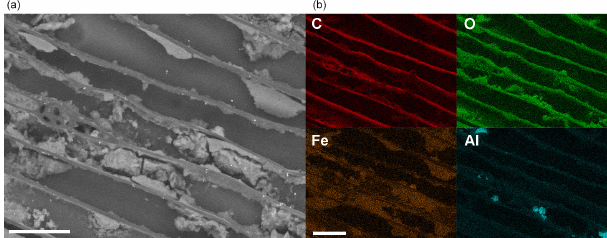
Figure 6. Elemental mapping by SEM-EDS for the mineral-bearing OC from the mountain soil. (a) SEM backscattering image (The bright spots inside are gold nanoparticles for coating). (b) Elemental mapping of C, O, Fe, and Al. Scale bars are